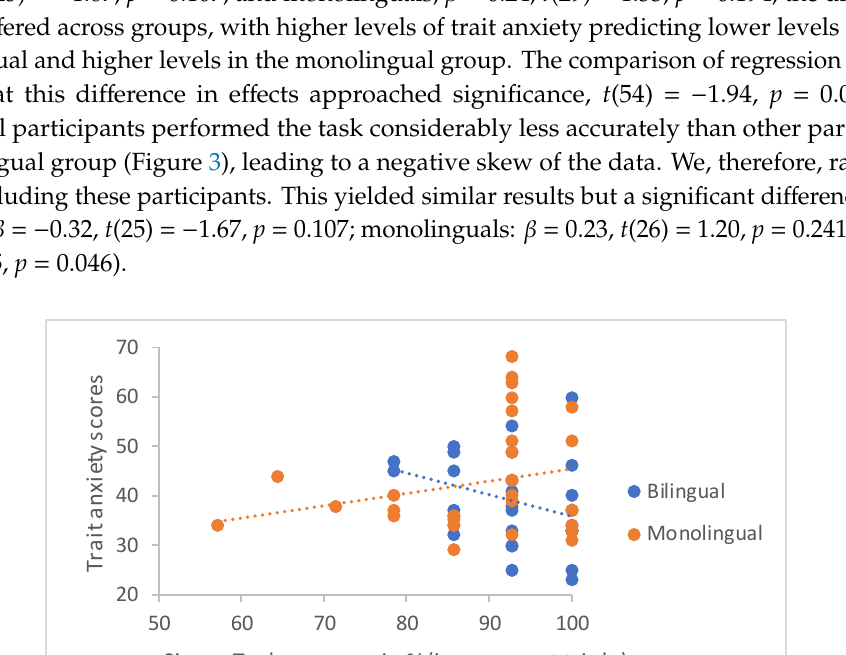
Table 6. Group means of Simon task performance (standard deviations in brackets).